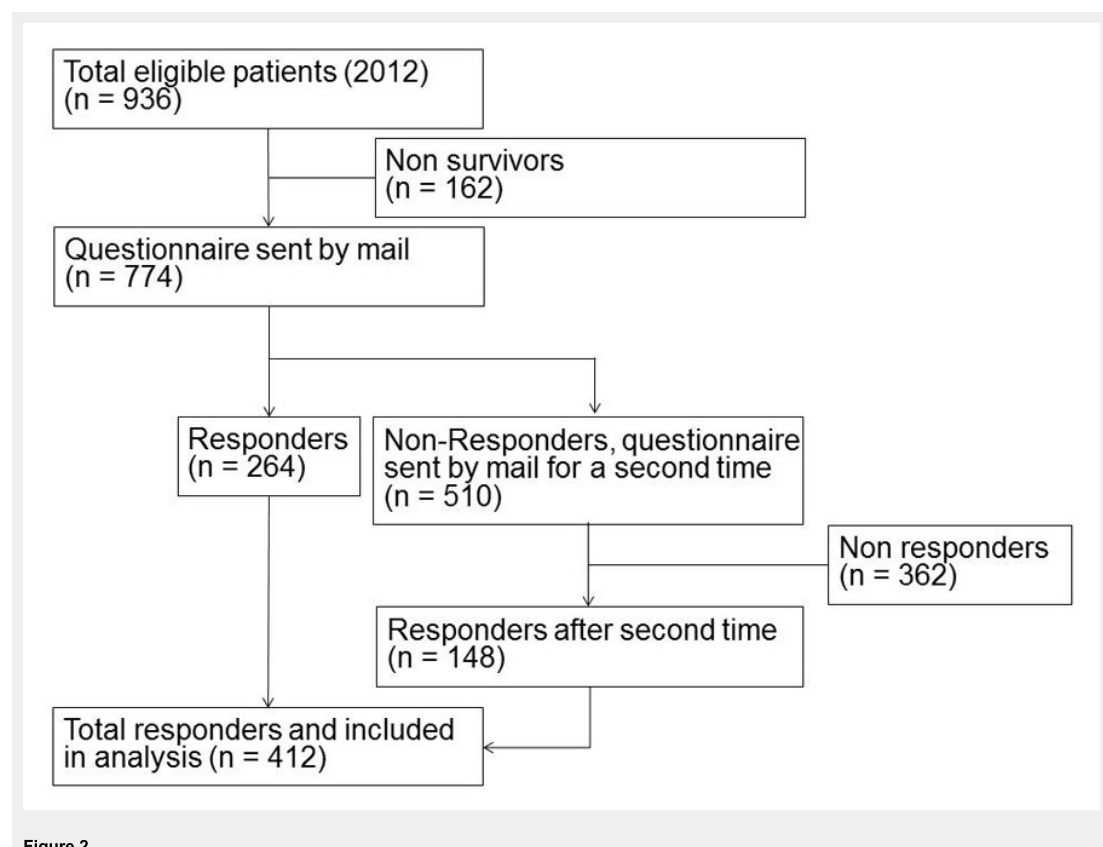
Figure 2 Patient inclusion flow chart